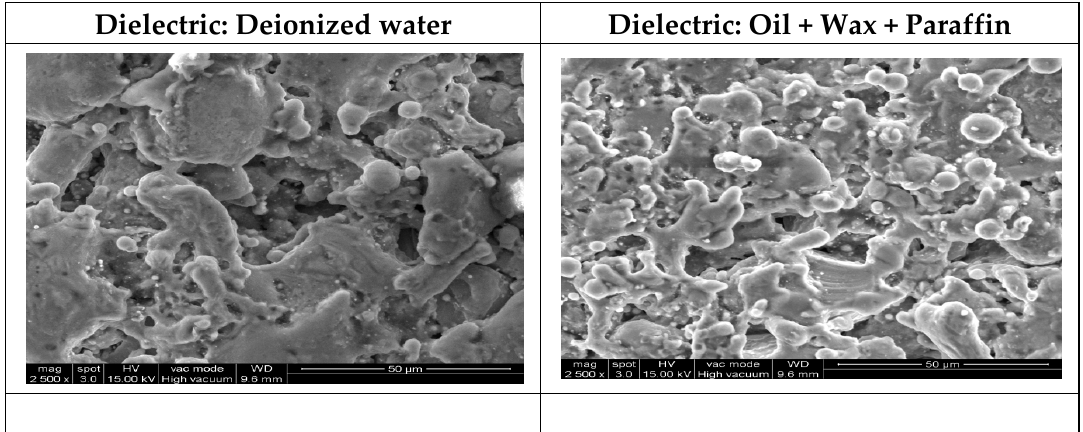
Figure 12. XRD plot and residual stress analysis of wire electrical discharge machined Al-SiC-TiC metal matrix composite surface.